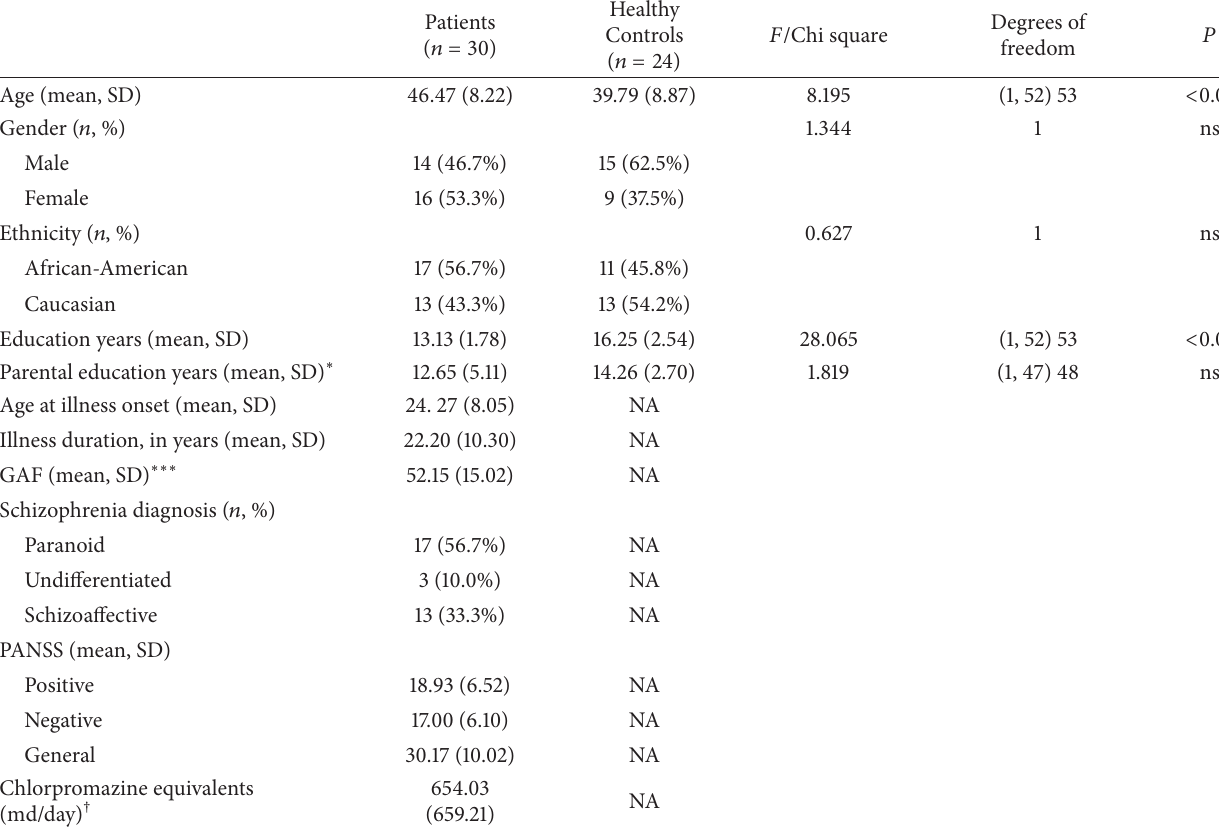
Table 1: Characteristics for demographic, functional, and clinical